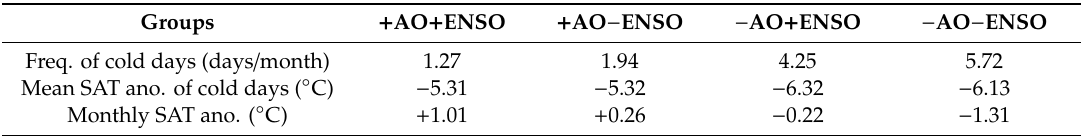
Table 1. Extreme cold days frequency, mean of sea surface temperature (SAT) during cold days, and monthly SAT anomalies according to a combination of Arctic Oscillation (AO) and El Niño Southern Oscillation (ENSO) phases. Groups + AO + ENSO + AO − ENSO − AO + ENSO − AO − ENSO Freq. of cold days (days / month) 1.27 1.94 4.25 5.72 Mean SAT ano. of cold days ( ◦ C) − 5.31 − 5.32 − 6.32 − 6.13 Monthly SAT ano. ( ◦ C) + 1.01 + 0.26 − 0.22 −